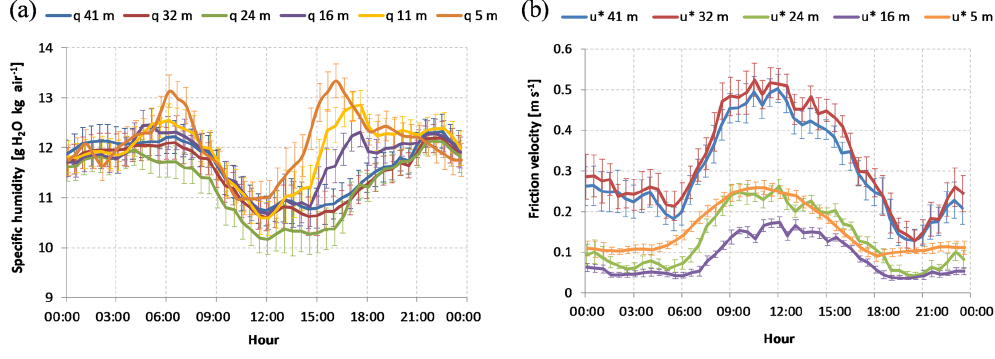
Figure 1. (a) Average diel course of specific humidity ( q ) at the five levels; (b) average diel course of friction velocity ( u ∗ ) at the five levels. Vertical bars represent the standard error of the